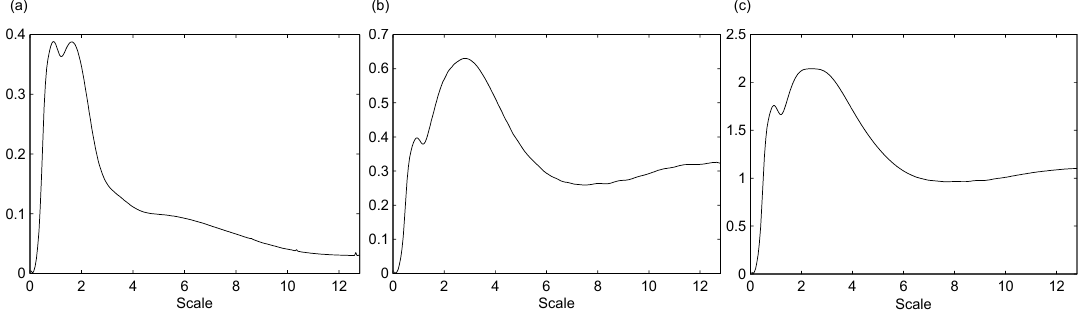
Figure 4. Normalized inner scalograms of series 1, 2 and 3 (see ( a ), ( b ) and ( c ) respectively), using Daubechies eight–wavelet. The scale runs from 0.05 to